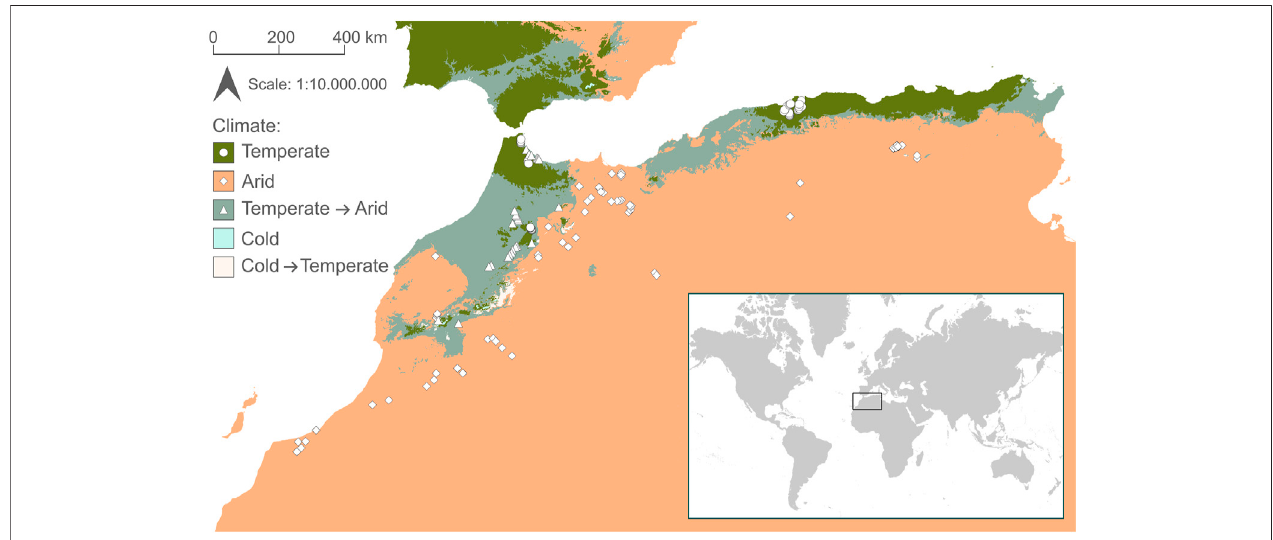
FIGURE 1 | Map of sample sites in Northwest Africa. Shape of points indicates climatic region (dots (cid:1) temperate; diamonds (cid:1) arid; triangles (cid:1) temperate climate predicted to shift to arid by 2071 – 2100). Climate classi fi cation is based on Beck et al. (2018).